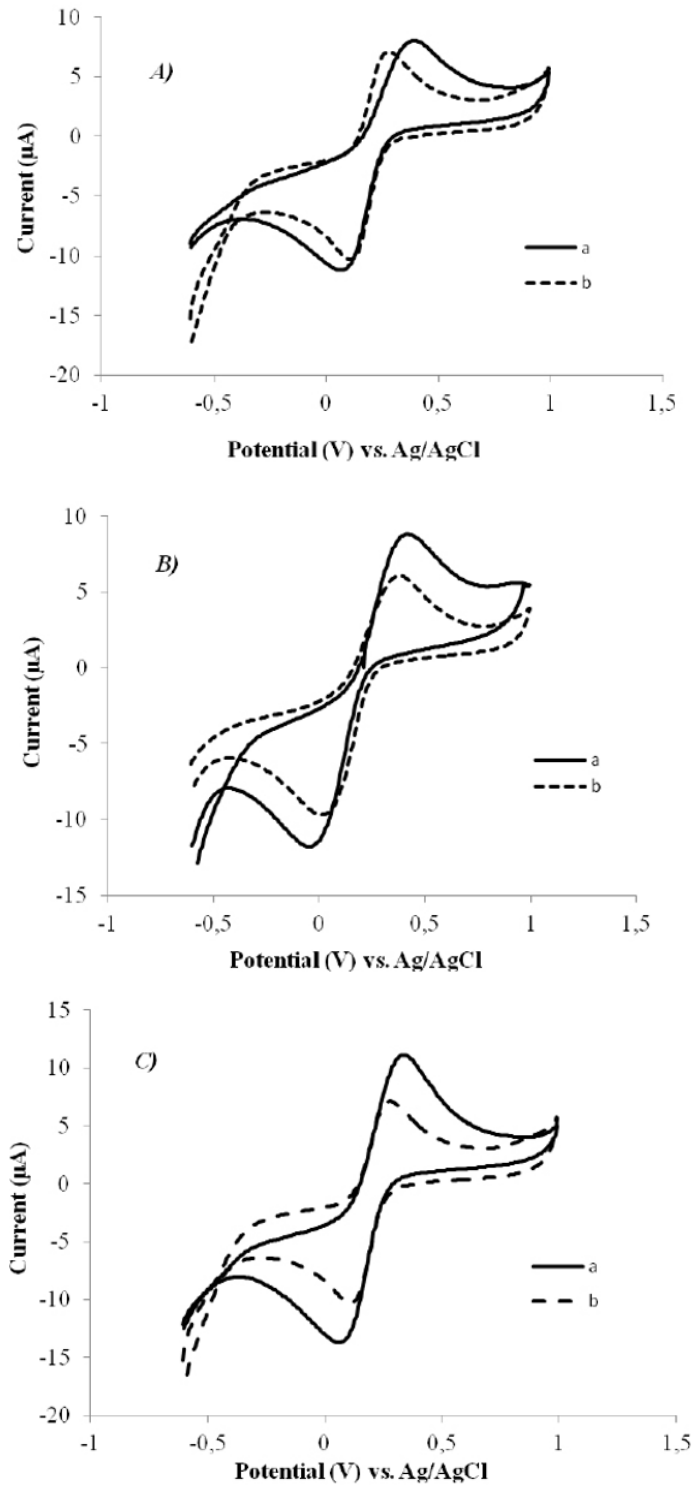
Figure 2. Cyclic voltammograms ( A,a; B, a; C,a) recorded for 10 -6 mM K at : A)